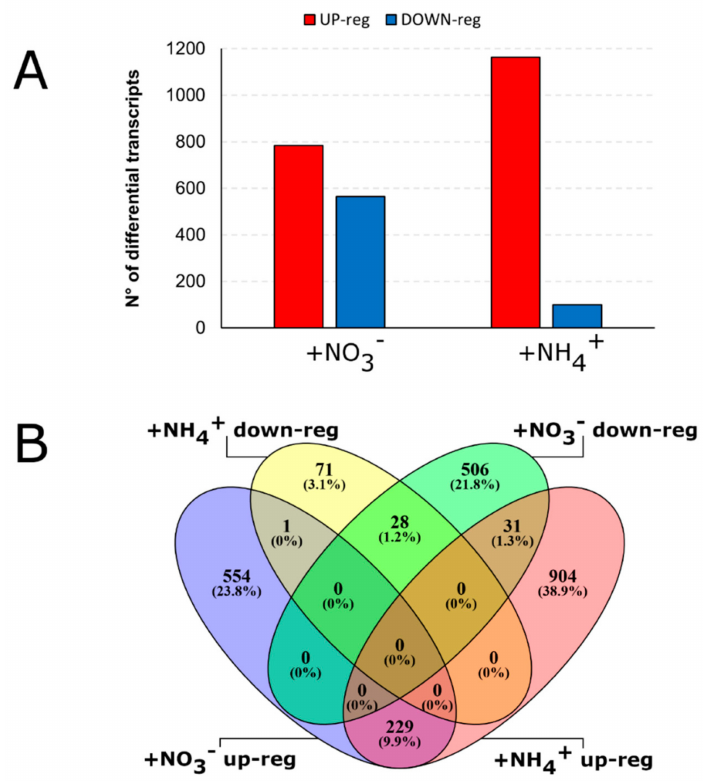
Figure 1. Distribution of di ff erentially expressed genes (DEGs) identified (log2 FC >| 0.58 | ; FDR ≤ 0.05) by RNA-Seq analysis from the comparison between NO 3 − or NH 4 + supplied maize seedlings for 24 h with respect to the control (-N, nitrogen deficient